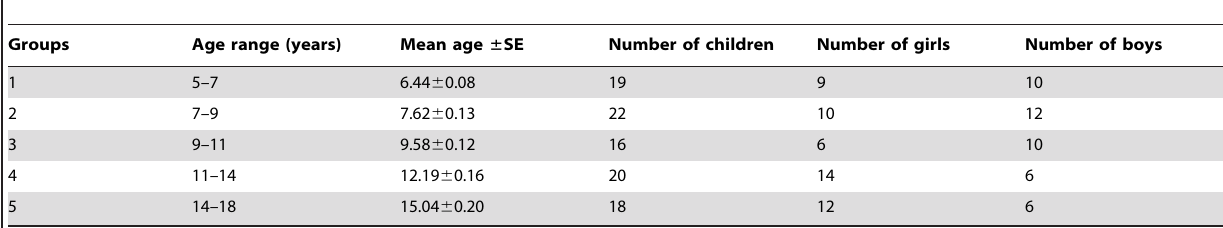
Table 1. Composition of the age-related groups of children with the mean, standard error.